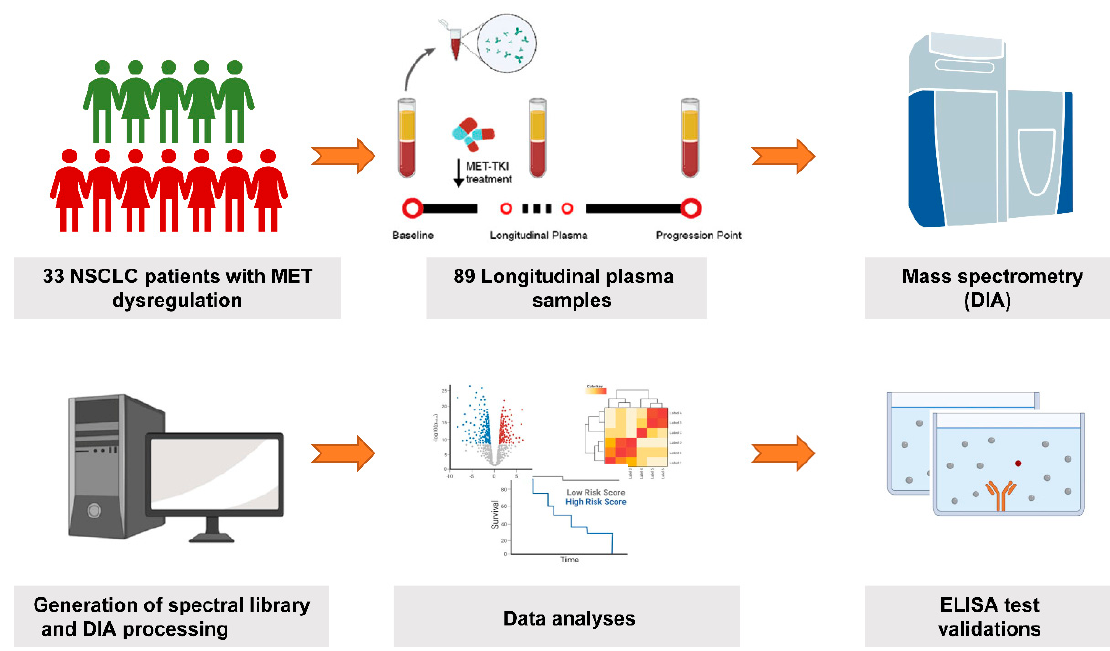
Figure 1. Summary of MET dysregulated NSCLC patients and study workflow.